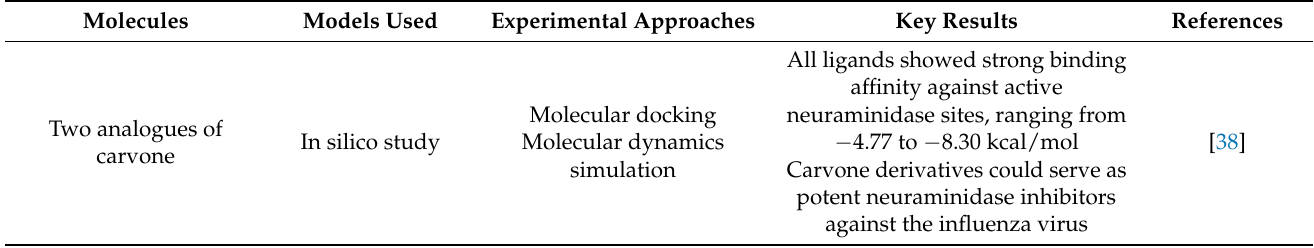
Table 5. Antiviral activity of carvone